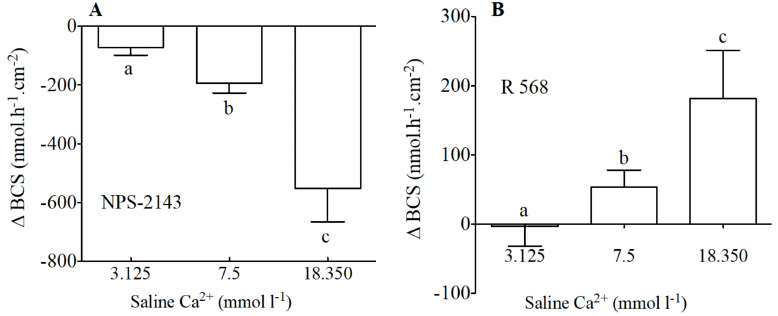
Figure 4. Variation of HCO 3 − secretion ( ∆ nmol · h − 1 · cm − 2 ) as measured in Ussing Chambers by pH-Stat in preparations from the anterior intestine of juvenile sea bream with an apical saline 3.125, 7.5 and 18.350 mmol · L − 1 Ca 2+ in response to apical addition of 100 µ M of NPS-2143 ( A ) and 100 µ M of R 568 ( B ). Each bar represents the mean ± SEM ( n = 5–7). Different lowercase letters indicate